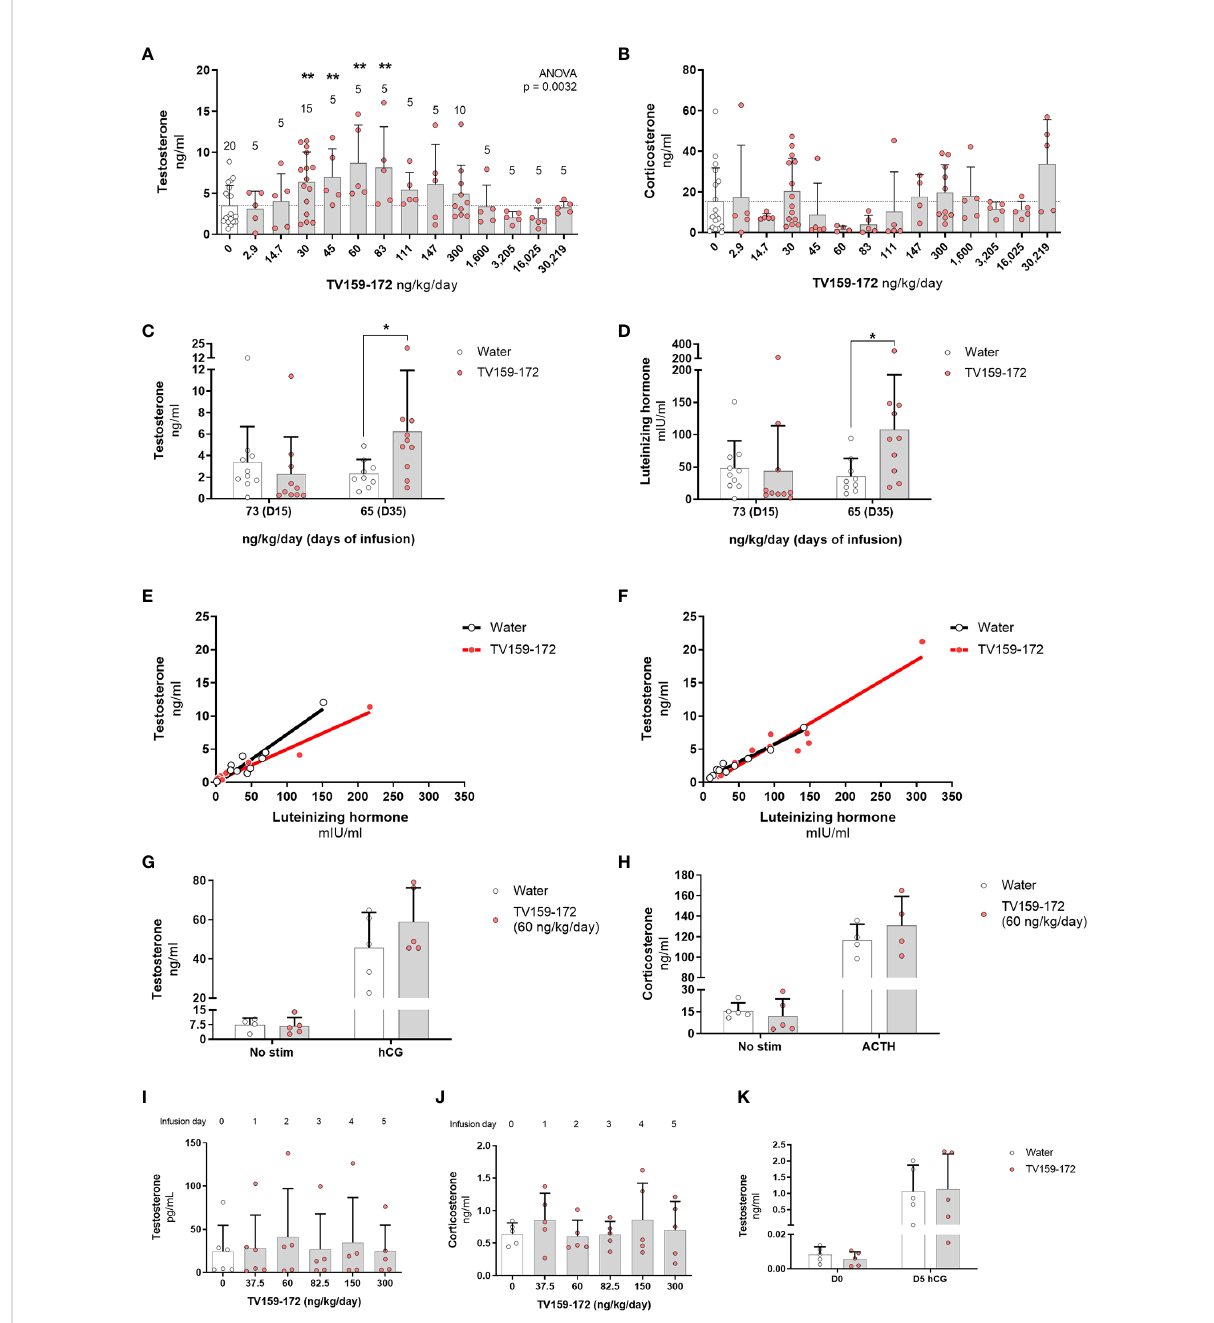
FIGURE 2 (A, B) Subcutaneous infusion of TV159-172 increases testosterone levels. Sprague-Dawley rats were implanted with osmotic pumps delivering various concentrations of TV159-172 for 1 week with graphs showing the results of three pooled rounds. Testosterone (A) and corticosterone (B) levels were measured in serum at the end of the treatment. Data shown represent means ± standard deviation. The N is depicted on top of each bar. p*< 0.05, p**<0.01. (C – F) Chronic infusion of TV159-172. Sprague-Dawley rats were implanted with osmotic pumps and plasma samples were collected 15 and 35 days after implantation. Plasma testosterone (C) and luteinizing hormone (D) levels are shown. (E , F) Correlation between testosterone and luteinizing hormone levels in samples collected at infusion day 15 and 35. Data shown represents means ± standard deviation (N=10); p* < 0.05. (G, H) Stimulation with supraphysiological levels of hCG or ACTH. Sprague-Dawley rats were implanted with subcutaneous osmotic pumps delivering TV159-172 for 1 week. Serum testosterone (G) and corticosterone (H) levels from rats not stimulated or stimulated with hCG or ACTH for 90 min are shown. Data shown represent means ± standard deviation (N=5). (I – K) Effects of TV159-172 in hypophysectomized rats. Plasma testosterone (I) and corticosterone (J) levels in Sprague-Dawley rats implanted subcutaneously with programmable pumps delivering increasing concentrations of TV159- 172 every 24 hrs. (K) Serum testosterone levels in hypophysectomized rats infused with TV159-172 for one week and stimulated with hCG for 90 min. Data shown represent means ± standard deviation